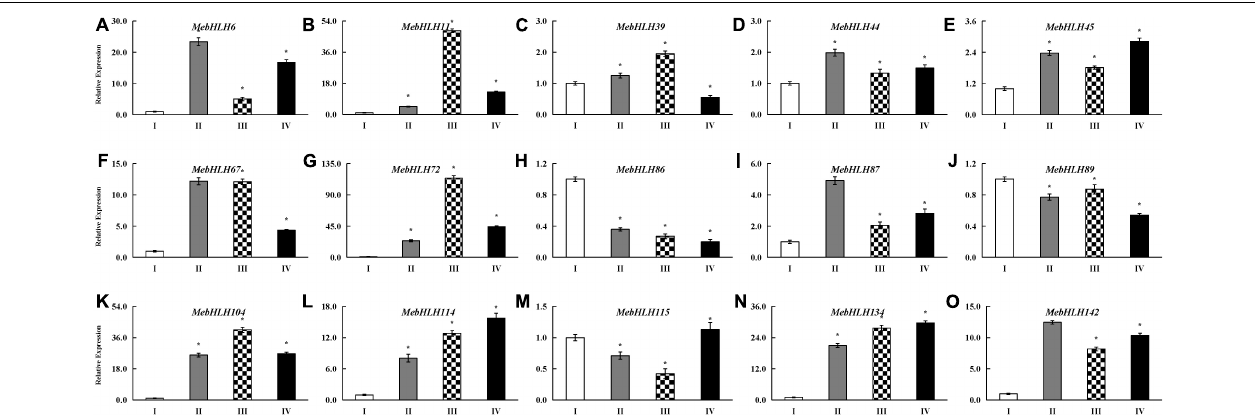
FIGURE 7 | qRT-PCR results for MebHLHs under PPD process. qRT-PCR was used to analyze the expression profiles of 15 up-regulated MebHLH genes according to RNA-seq. PPD degrees I-IV were described in Figure 6A , (A–O) indicates the 15 MebHLH genes tested, respectively. The relative expression levels are normalized to MeActin . The data represent the mean of three biological replicates. The x -axis represents four materials from different PPD stage. The y -axis represents the relative expression levels of MebHLHs . All data are the Means ± SE of three independent experiments. Error bars indicate the standard